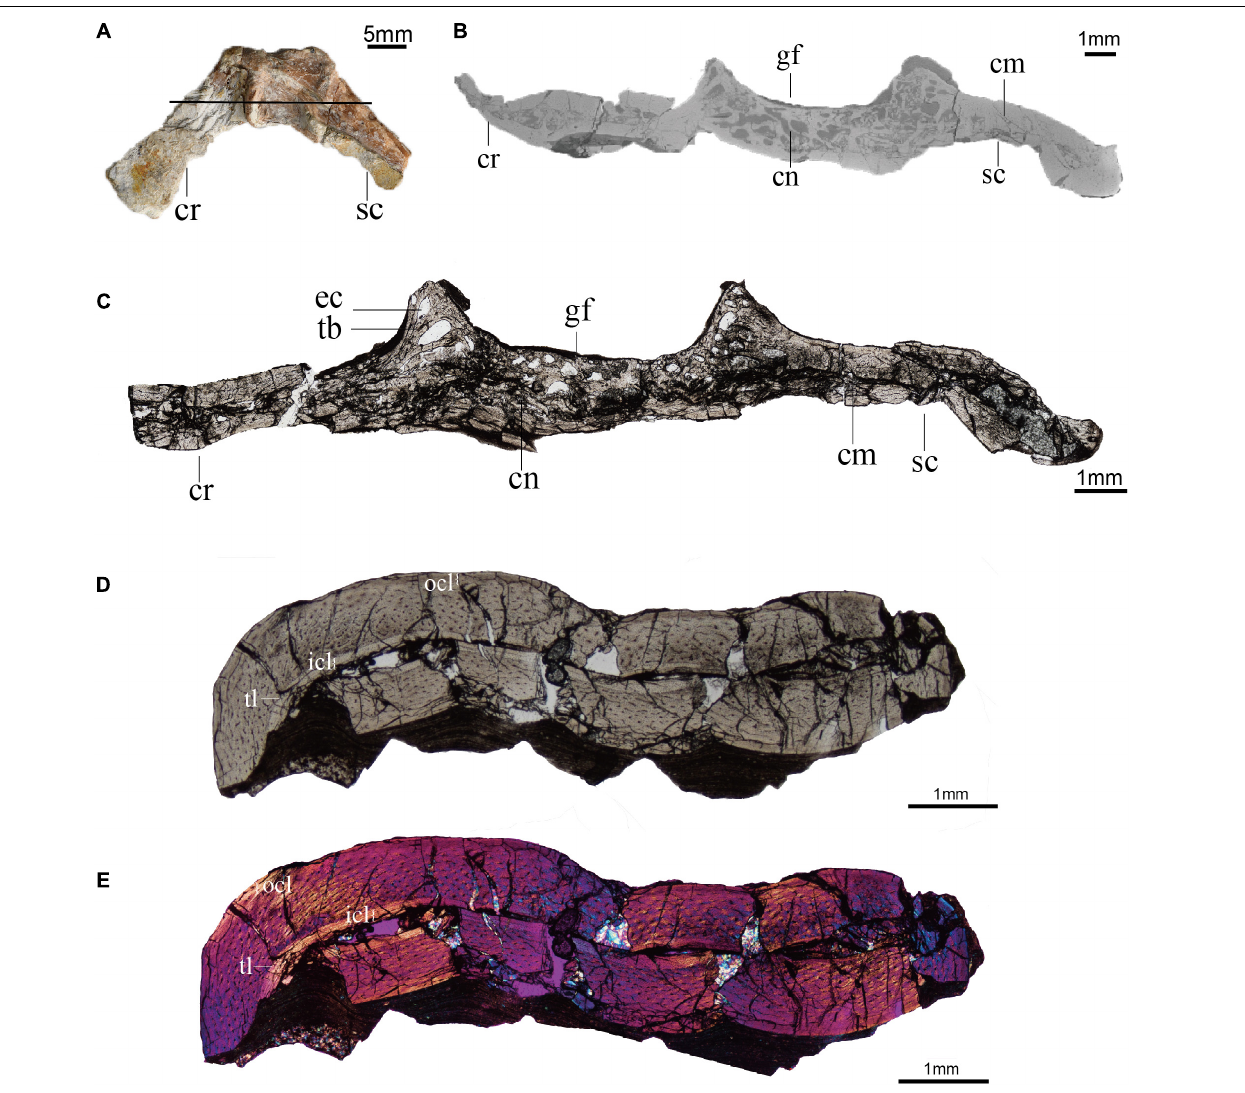
FIGURE 3 | Histology (ground-sections) of Confuciusornis (IVPP V11521). (A) Gross morphology of the scapulocoracoid; (B) CT slice of pectoral girdle indicated by the black line in panel (A) ; (C) Associated histological section indicated by the black line in panel (A) , magnified region showing the compact bone connecting the scapula and coracoid is in Supplementary Figure 1A ; (D) histological section of the humerus; (E) polarized light image of panel (D) . cm, compact bone; cn, cancellous bone; cr, coracoid; ec, erosion cavity; gf, glenoid fossa; icl, inner circumferential layer; ocl, outer circumferential layer; sc, scapula; tb, trabecula; tl, tide